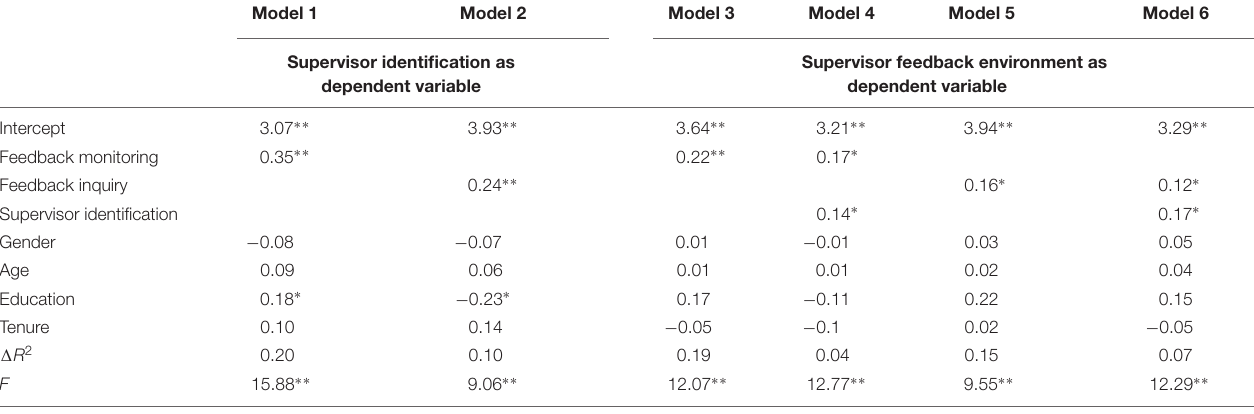
TABLE 3 | Hierarchical regressions for the impact of feedback monitoring/inquiry and supervisor identification on supervisor feedback environment.